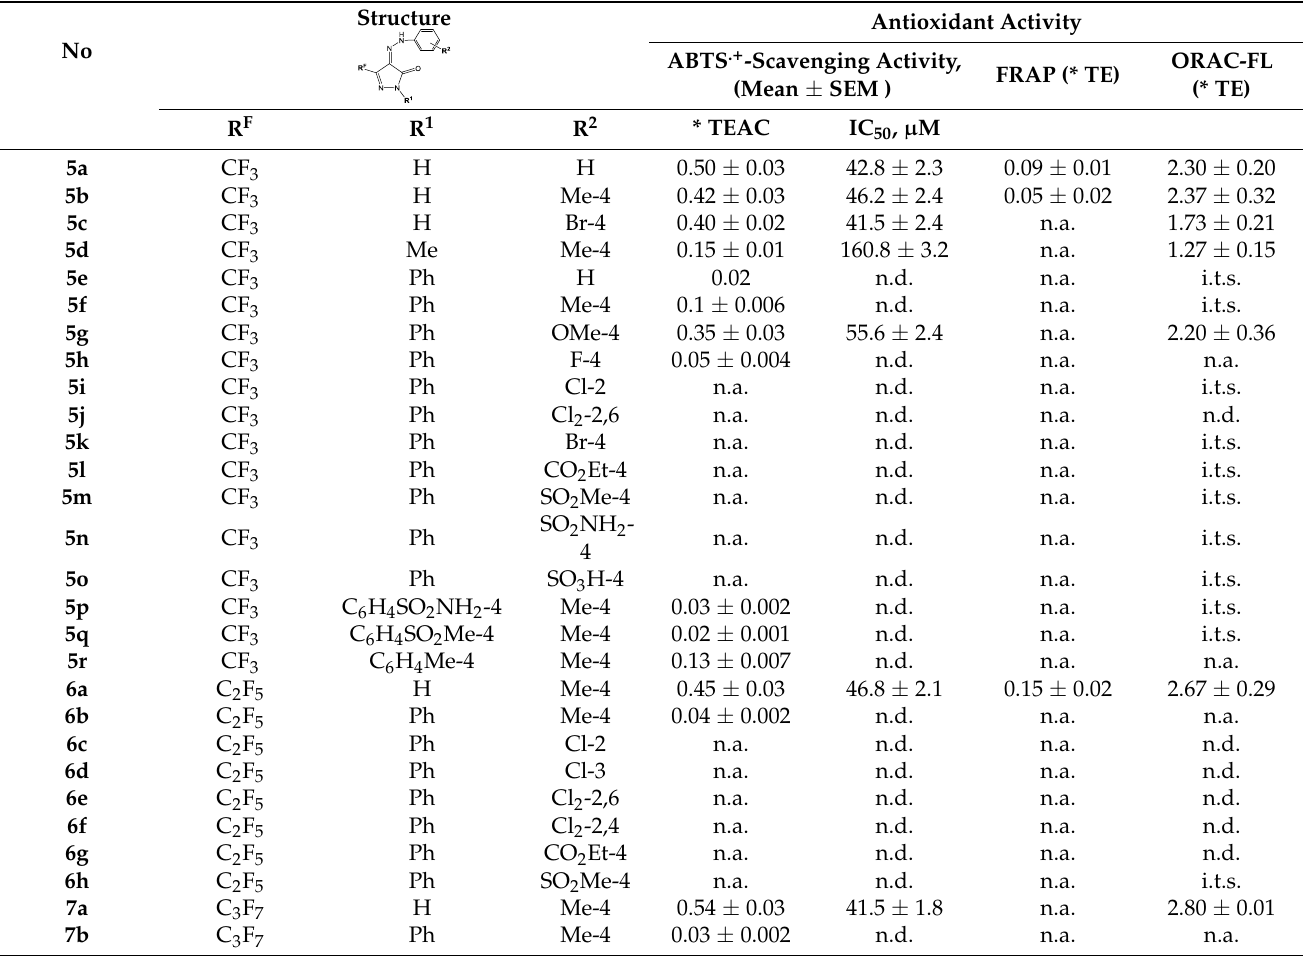
Table 5. Antioxidant activity of 4-AHPs 5–9 . Structure